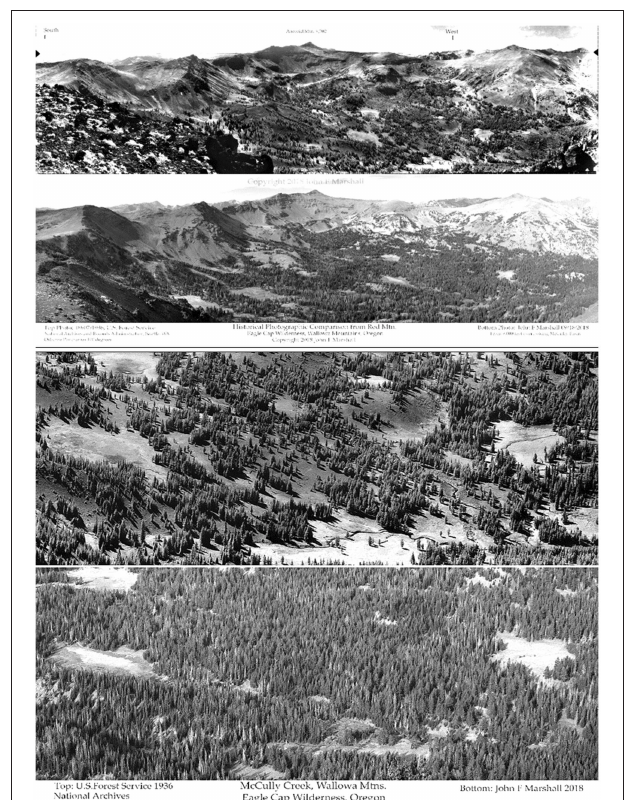
FIGURE 11 | Top pair, Panoramic (120 ◦ ) comparison of high elevation (2,400–2,700m) cold forests of the McCully Creek basin. Top photo is from 1936, from the William Osborne collection, looking WSW to Aneroid Mountain from the top of Red Mountain. Forests are mixed lodgepole pine, subalpine fir, and Engelmann spruce. Notice that the headwaters of this basin was historically dominated by dry and wet meadows with interspersed ribbons of forest. Bottom photo of the pair is from 2018, taken by John Marshall. Notice the infilling of forest and decline in meadow area. Bottom pair, close-up of a portion of the top photo pair. The scene is McCully Creek. Notice in the top photo, that size classes of open-grown trees are variable indicating that meadow invasion/expansion is dynamic in the interval between fires. In the bottom photo, widespread bark beetle mortality is indicated by gray lodgepole pine and spruce snags, which are absent in the top photo. Loss of meadow is conspicuous in the bottom